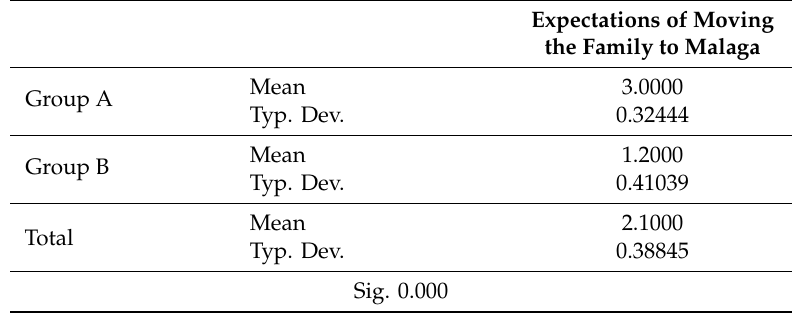
Table 14. Expectations of moving the family to Malaga.